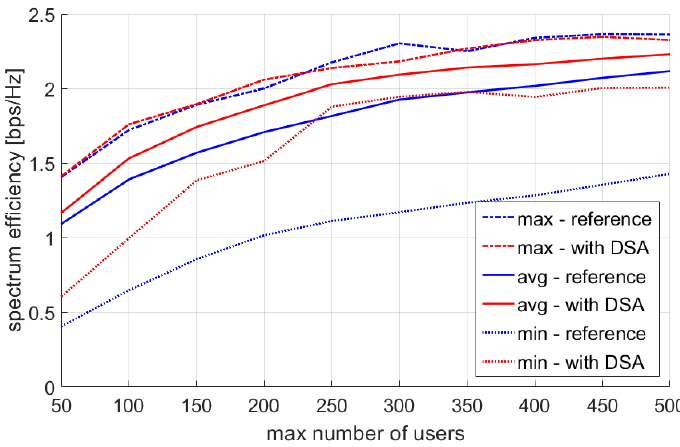
Figure 7. Single simulation repetition results—user bitrate.